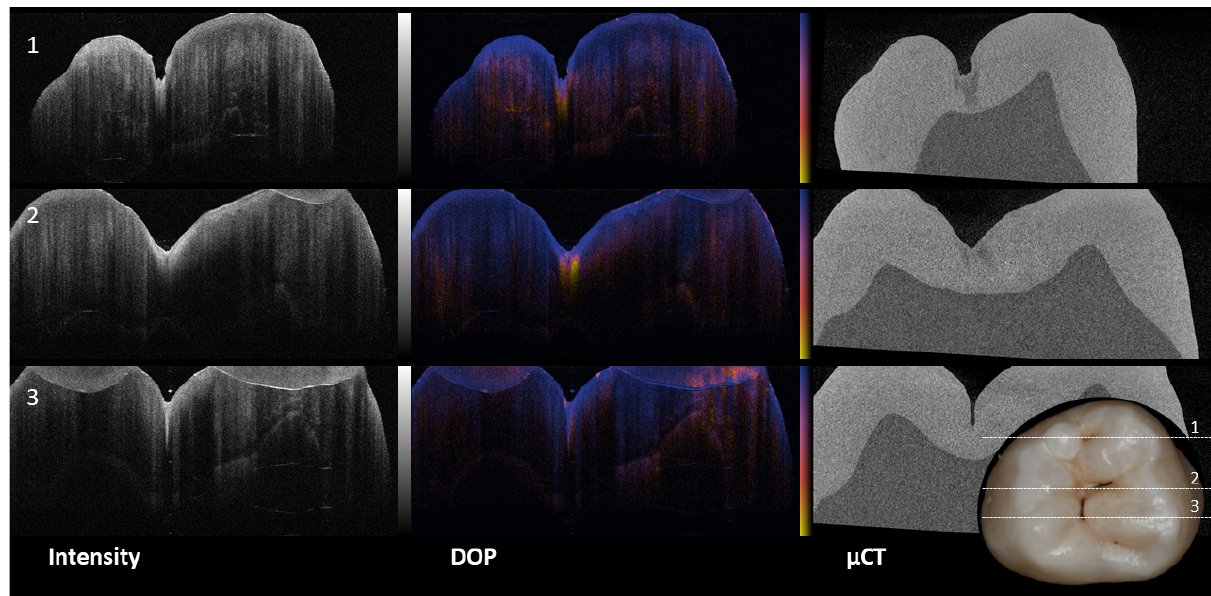
Figure 1. Comparison of PS-OCT and µ CT slices from co-registered volumes: Intensity (-2...41 dB), degree of polarization (DOP) with intensity overlay (DOP: 0.25...1, Int: -2...28 dB) and spatially aligned µ CT images, spanning 9.6 mm in lateral and 4.3 mm in axial direction. Photograph (bottom right) of the occlusal surface with slice